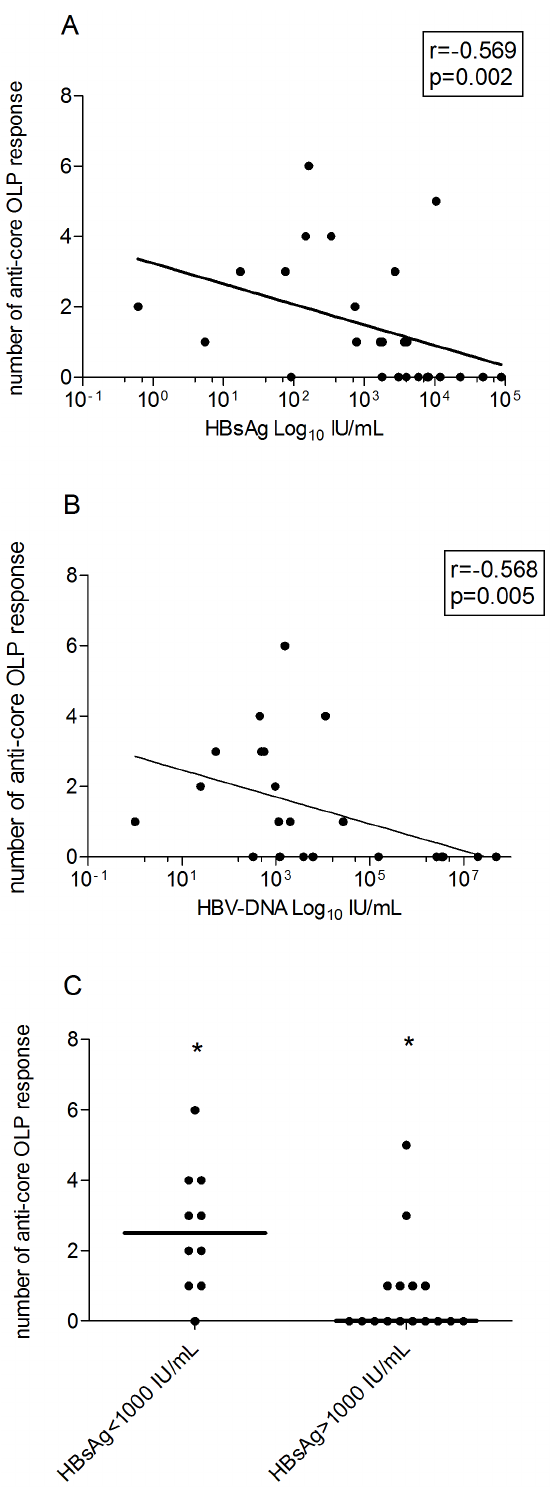
Figure 3. HBV-core specific T cell response and HBV serovir- ological markers in untreated patients (IC and CHB). A) Correlation between the breadth of the HBV core specific T cell response (number of anti-core targeted peptides) and HBsAg serum levels (IU/mL) in the 26 treatment-naive patients (IC and CHB patients). Regression line, r coefficient and p value (Spearman Ranks test) are shown. HBsAg axis in logarithmic scale. B) Correlation between